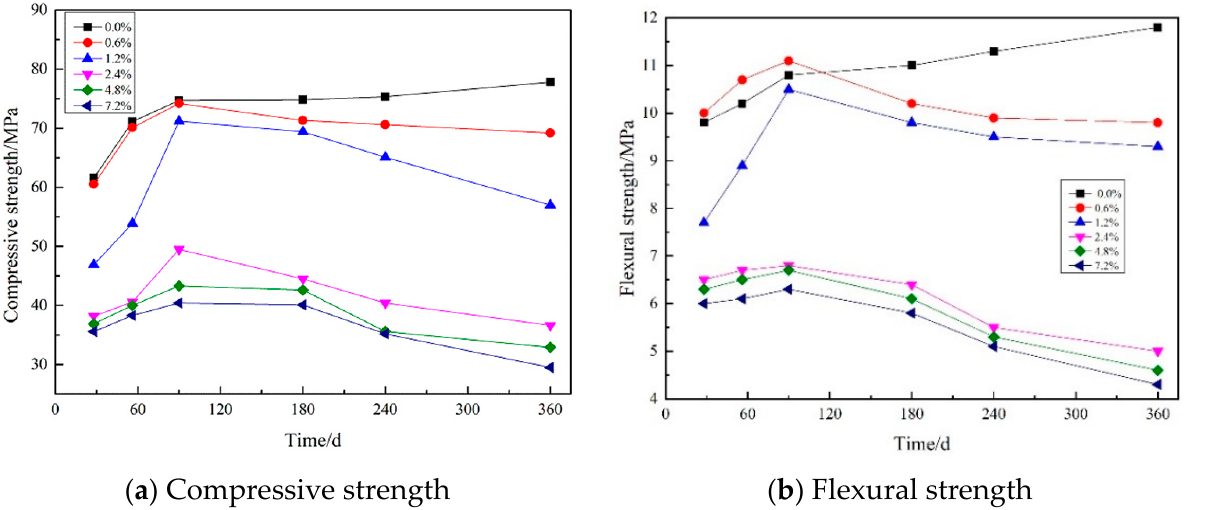
Figure 13. Strength of mortars with different SO 3 content in aggregate.